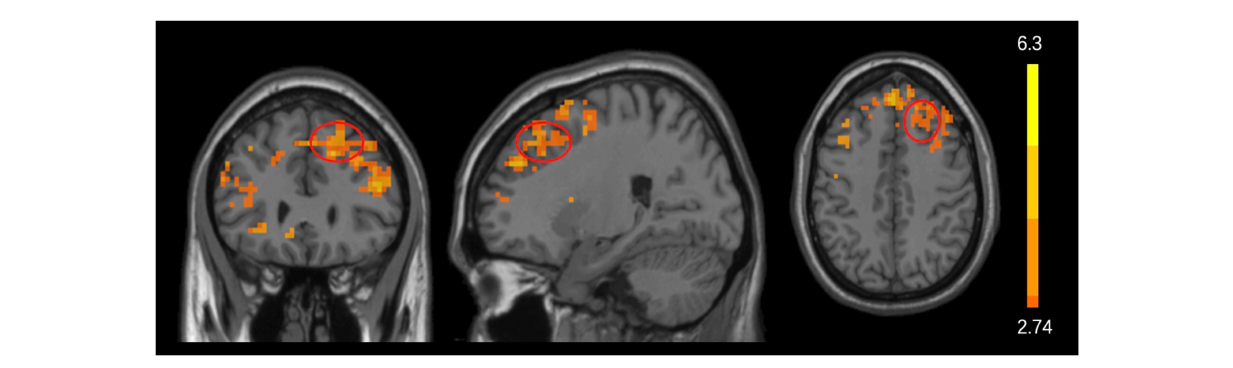
FIGURE3 Acupuncture effects before and after treatment. Significant changes in ALFF values before and after acupuncture treatment in the acu-group. Significantly increased (marked in warmer colors) ALFF values were found in the frontal cortex after acupuncture treatment. The red circle represents the frontal